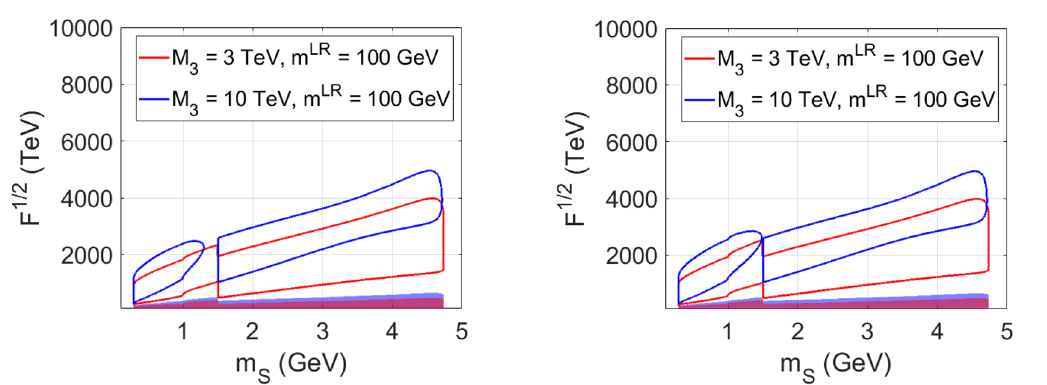
Figure 22 . Regions of sgoldstino model parameters to be explored in FASER-II experiment. Sgoldstinos are mostly produced in beauty meson decays and exhibit signatures of a pair of charged mesons (left plot) and both neutral and charged mesons (right plot) for m S < 1 . 5 GeV. Sgoldstinos with m S > 1 . 5 GeV decay into gluon pairs. A Q = 100 GeV. Shaded areas correspond to restrictions from table